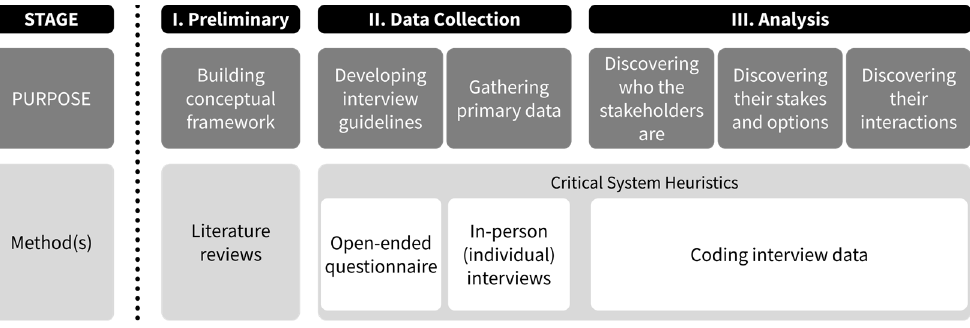
Figure 2. Research design.